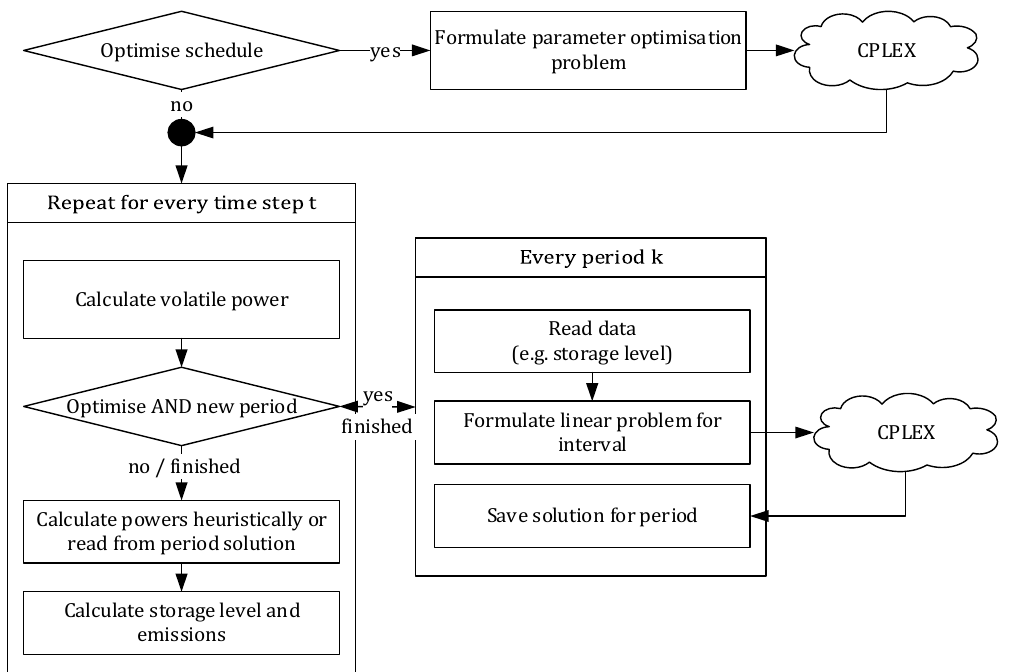
Figure 2. Simplified schematic program flow of CharL.